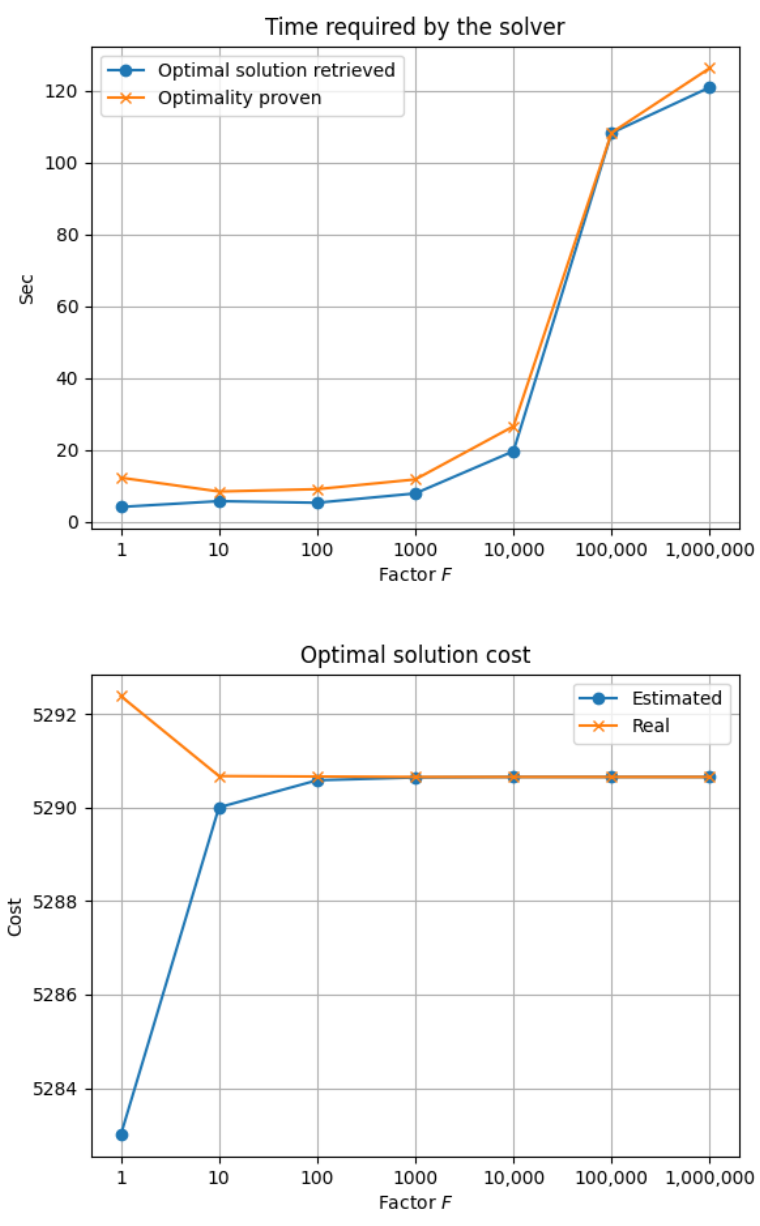
Figure 2. Times and optimal objective function cost for different values of the scaling factor F — instance berlin52_0_80_2_2_1 from